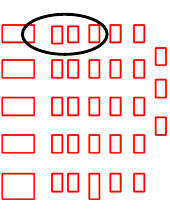
Figure 6. If height or width alignment takes precedence over top or bottom alignment, artifacts occur, cf. Figure